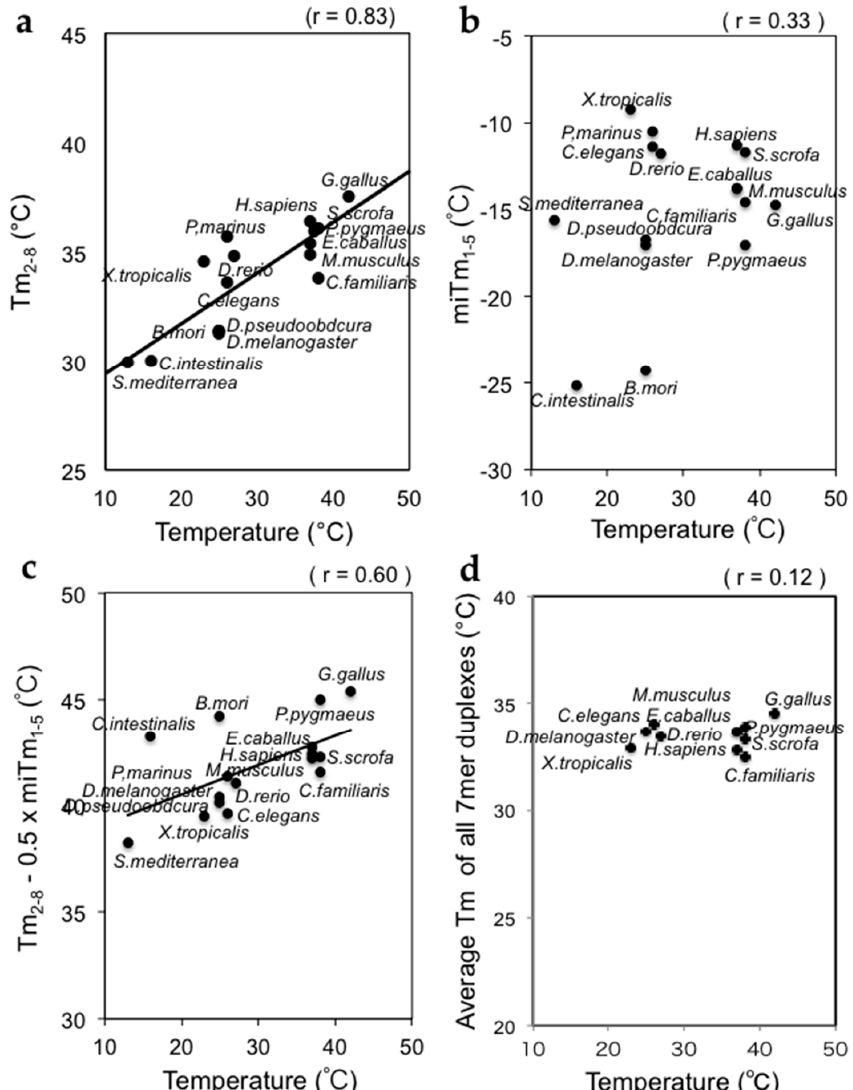
Figure 4. Strong correlations between the silencing parameters T m 2–8 and mi T m 1–5 , and the growth temperatures of various organisms. ( a ) A strong correlation was found between T m 2–8 and growth temperature; ( b ) A marginal correlation was found between mi T m 1–5 and growth temperature; ( c ) A strong correlation was found between T m 2–8 − 0.5 × mi T m 1–5 and growth temperature; ( d ) Almost no correlation was found between the average T m-values for all 7-mer tRNA sequences and growth temperature.